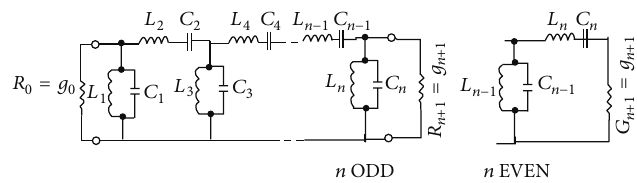
Figure 2: Circuit model of the band-pass filter derived from the primary template of a low pass filter.